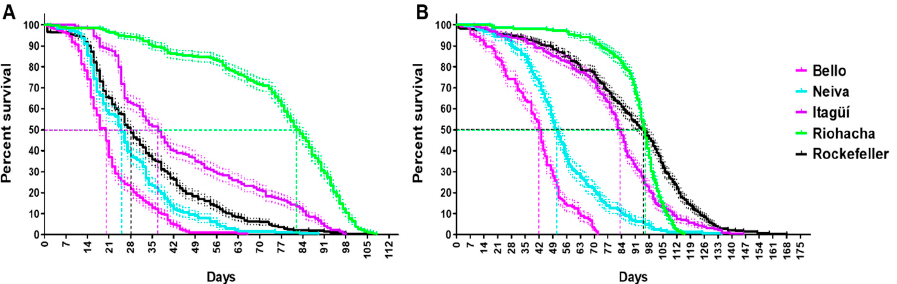
Figure 5. Percentage of survival for ( A ) males and ( B ) females of Colombian Ae. aegypti populations reared at 28 ± 1 °C temperature, 80 ± 5% relative humidity, and 12 h light: 12 h dark photoperiod. Kaplan–Meier plots were generated in GraphPad Prism. The mean and standard error (SE) are shown. The total number of replicates were: Bello and Neiva (4); Itagüí and Riohacha (5), and Rockefeller control (6). Each replicate started from a cohort of 100 eggs. Statistical differences were calculated by Log-rank (Mantel–Cox) test. Males: Chi square ( Χ 2 ): 499.9 df: 4 ( p < 0.05). Females: Χ 2 : 620.0 df: 4 ( p < 0.05). The dotted line represents the day at median survival for each population.